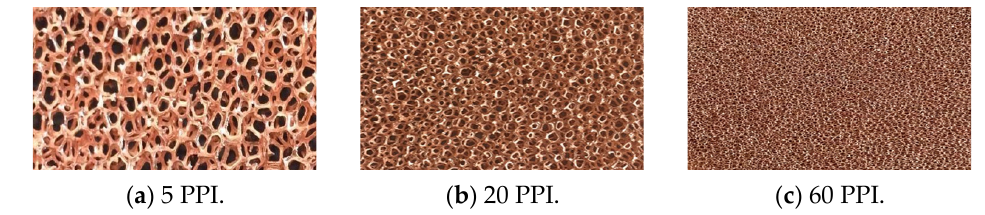
5 of 18 Table 1. Distribution of pressure taps on airfoil surface. Number